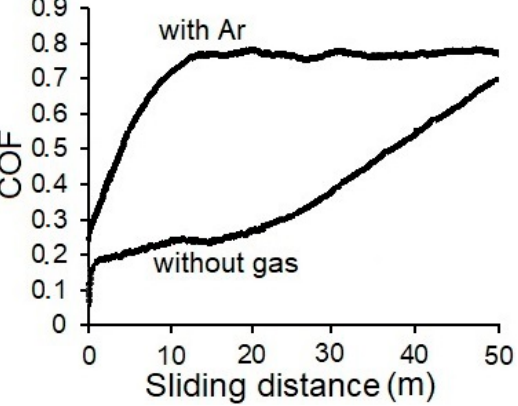
Figure 4. COF of WC/C coatings measured at room temperature (RT).